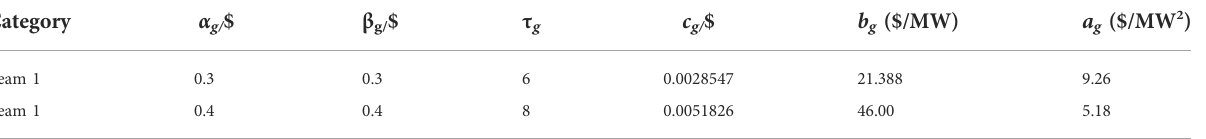
TABLE 2 Gas turbine cost